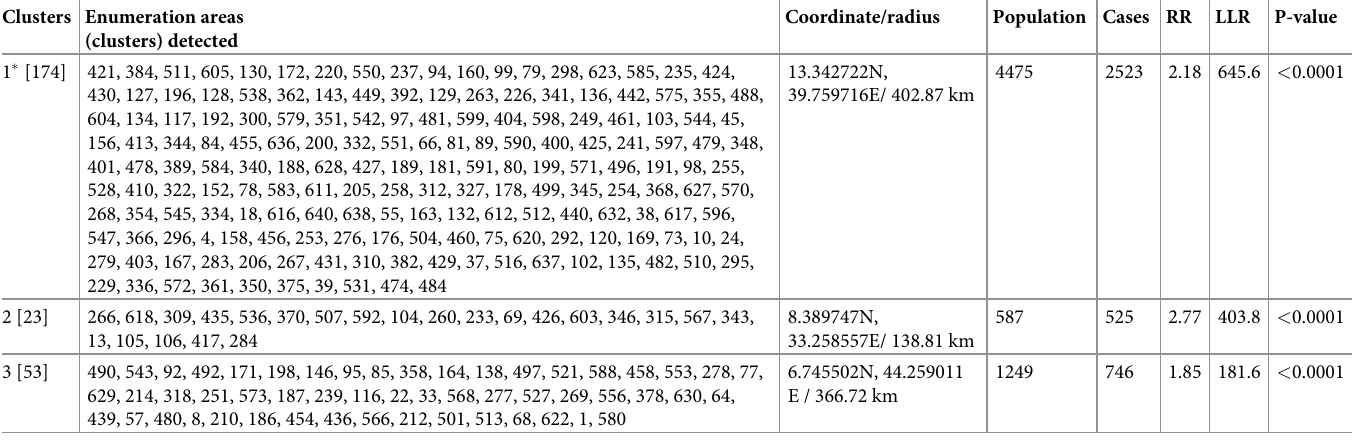
Table 3. Significant spatial clusters of open defecation practice among households in Ethiopia, EDHS 2016. Clusters Enumeration areas (clusters)